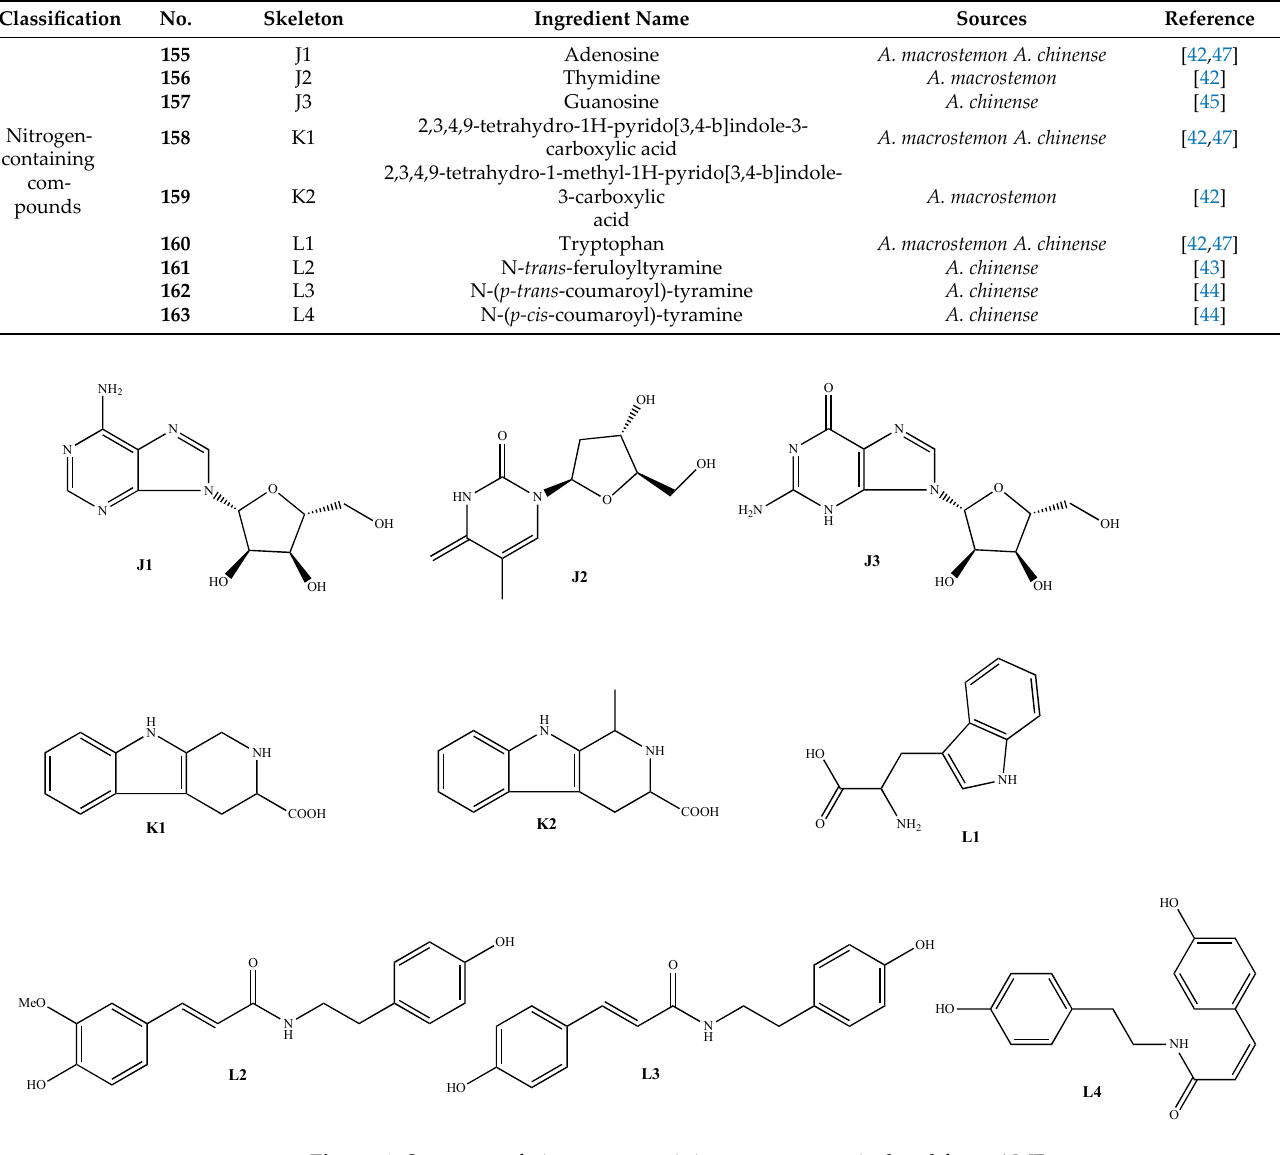
Table 7. List of phenylpropanoid and fl avonoid components isolated from AMB. Classification No. Skeleton